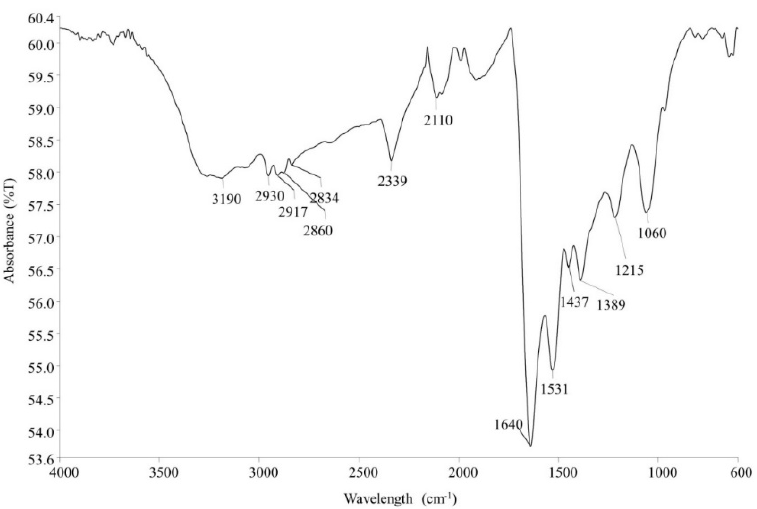
Figure 3. Fourier-transform infrared (FTIR) spectrum of Eh-AgNPs. Figure 3. F ourier-transform infrared (FTIR) spectrum of Eh-AgNPs. Figure 3. F ourier-transform infrared (FTIR) spectrum of Eh-AgNPs. Figure 3. F ourier-transform infrared (FTIR) spectrum of Eh-AgNPs.